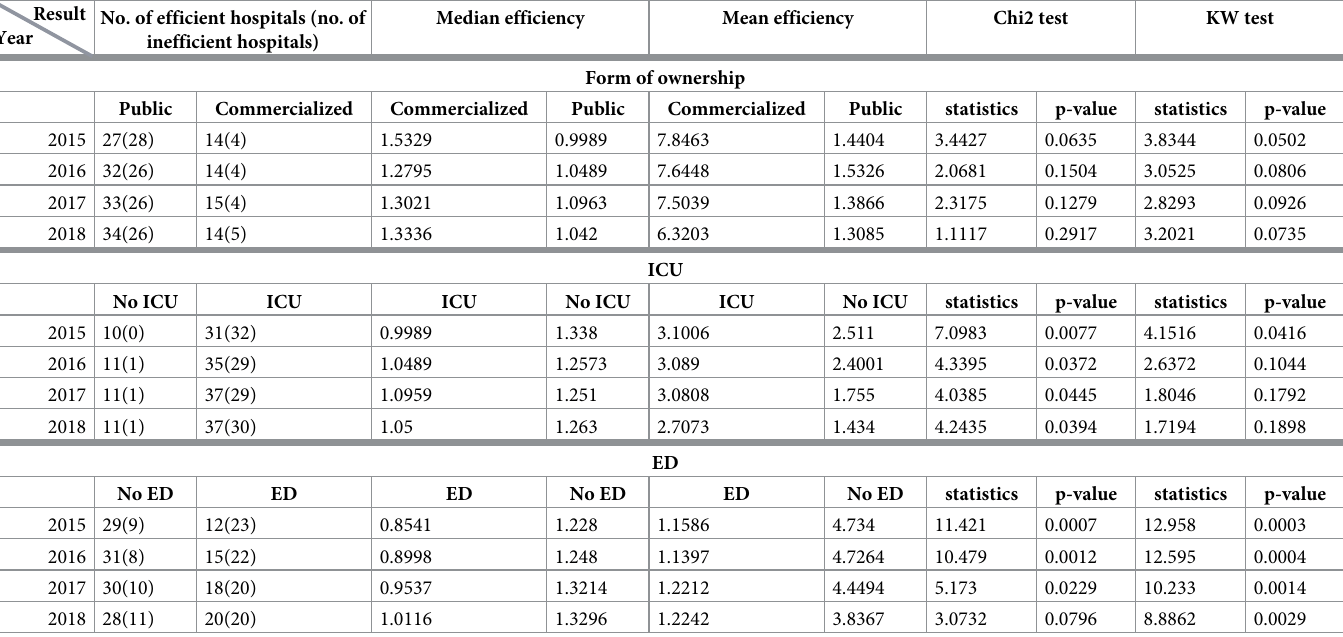
Table 4. Results of hospital efficiency with respect to ownership, ED and ICU ( general approach). No. of efficient hospitals (no. of inefficient